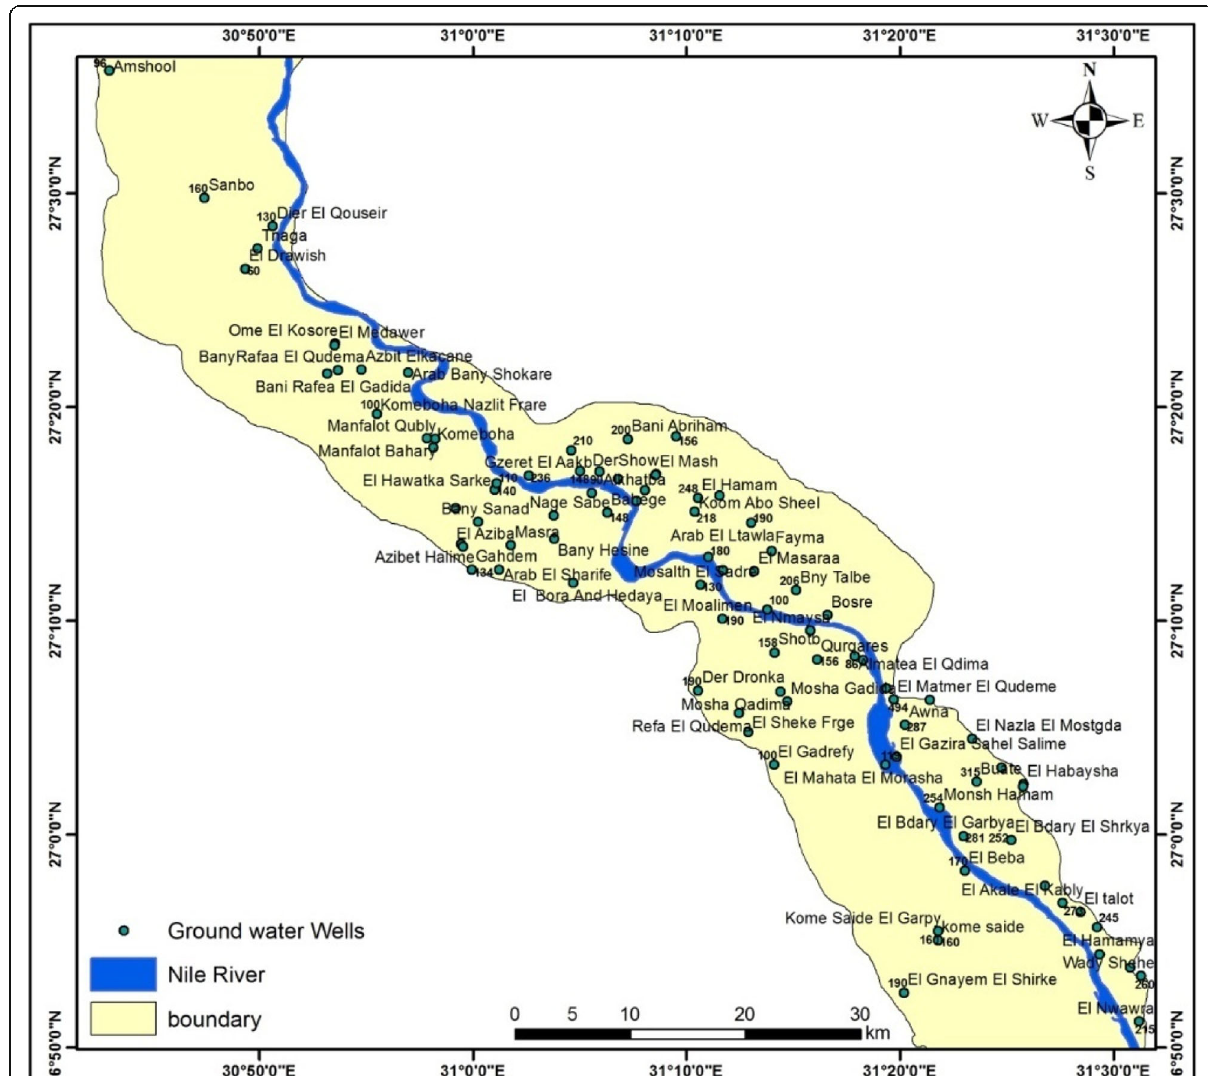
Fig. 4 Location map of groundwater wells, in Assiut